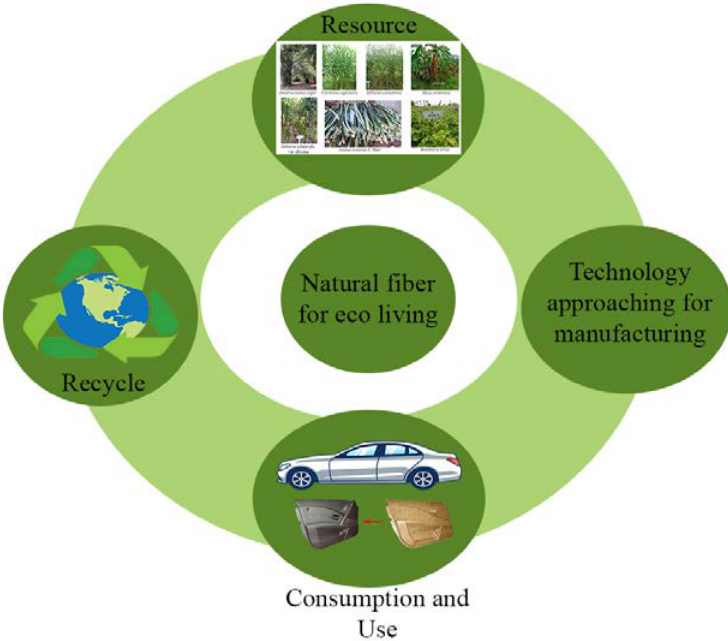
Figure 7. Circular economy concept to conserve the natural fiber for future eco living.